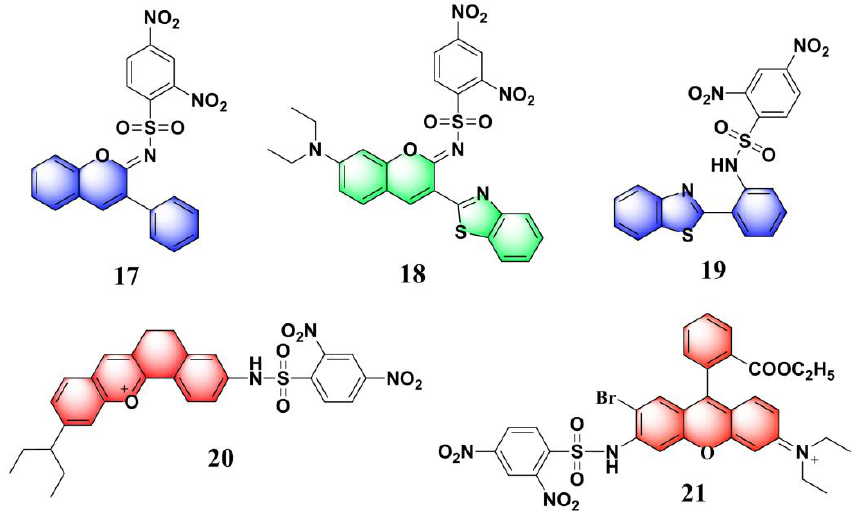
Figure 7. Other near-infrared (NIR) fluorescent PhSH probes ( 14–16 ) based on the recognition unit of 2,4-dinitrobenzenesulfonic amide.